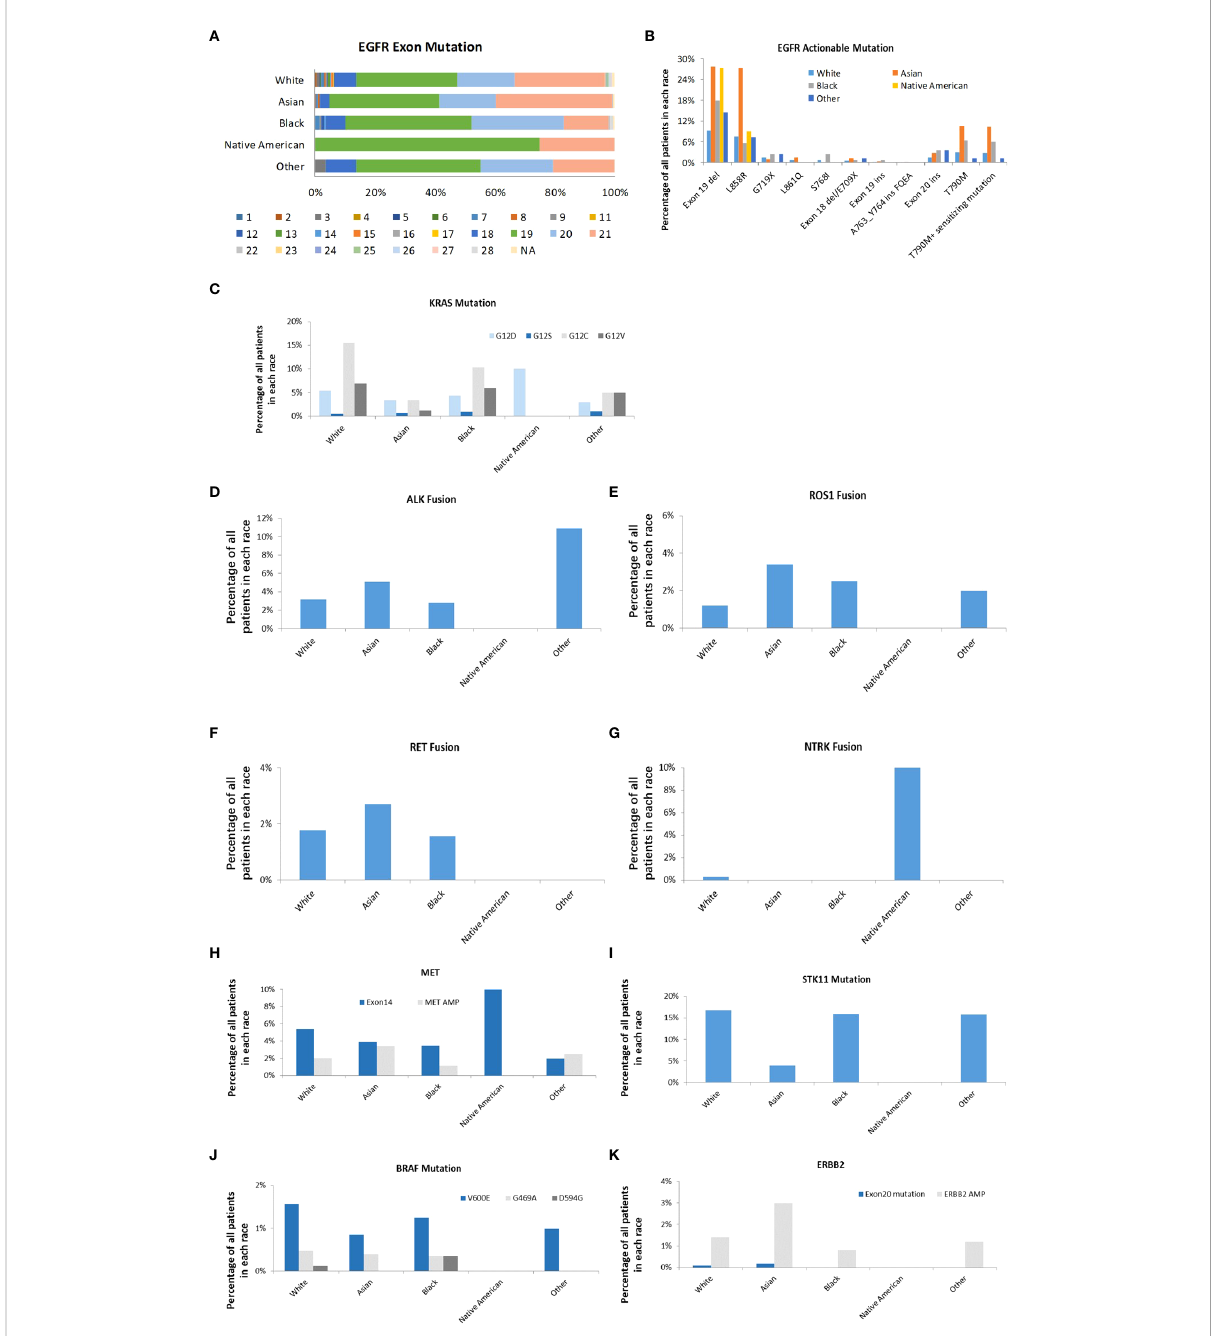
FIGURE 5 Actionable genomic alterations in different races. (A) . EGFR exon mutations in different races. The mutations in exon 1 to 28 were represented. (B) . The distribution of EGFR targets in different races. (C) . The distribution of KRAS subtypes in different races. (D) . The distribution of ALK fusion in different races. (E) . The distribution of ROS-1 fusion in different races. (F) . The distribution of RET fusion in different races. (G) . The distribution of NTRK fusion in different races. (H) . The distribution of MET exon 14 mutation and ampli fi cation in different races (I) . The distribution of STK11 in different races (J) . The distribution of BRAF subtypes in different races (K) . The distribution of ERBB2 exon 20 mutation and ampli fi cation in different